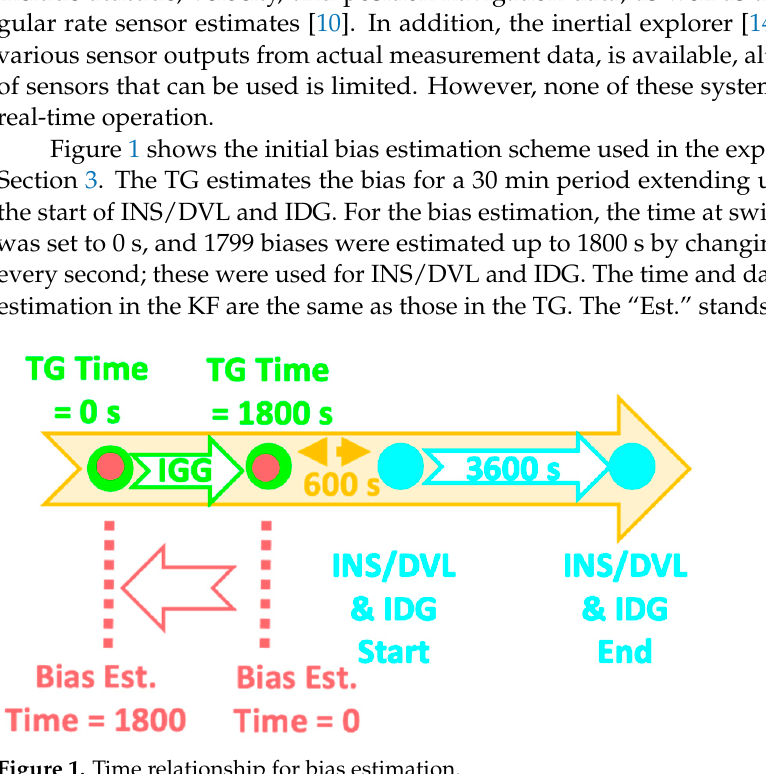
Figure 1. Time relationship for bias estimation.